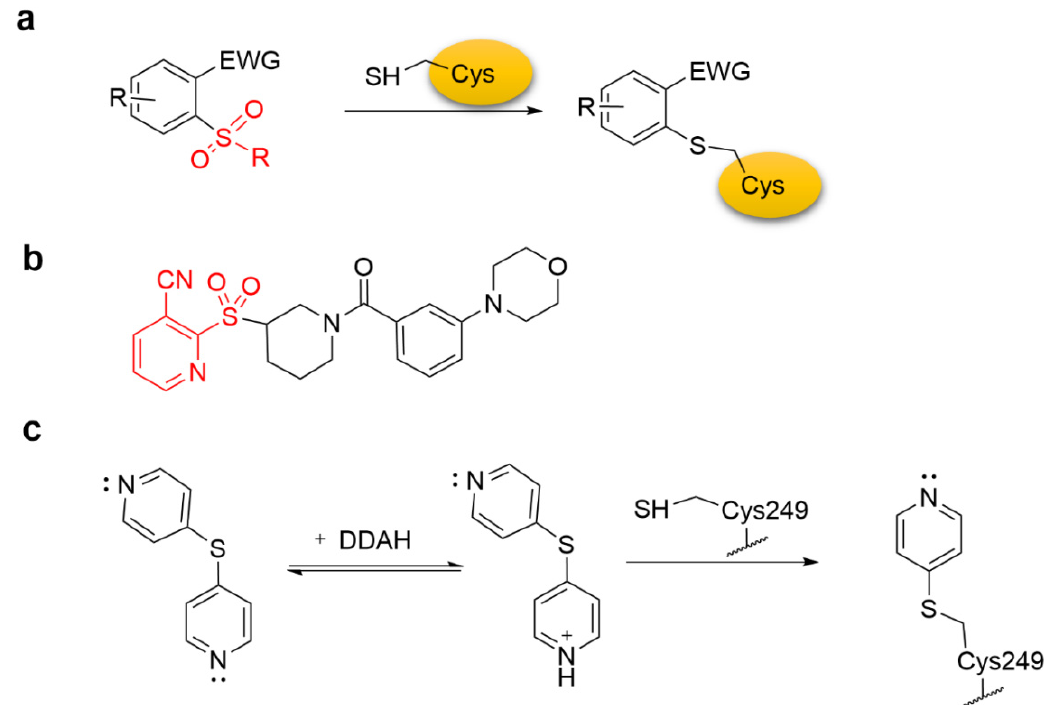
Figure 4. ( a ) The mechanism of 2 ‐ sulfonylpyridine forming a covalent adduct with cysteine. ( b ) Chemical structure of 2 ‐ sulfonylpyridine ‐ based irreversible covalent ADA modifier. ( c ) 4 ‐ Pyridyl ‐ sulfide undergoes S N Ar reaction with active site